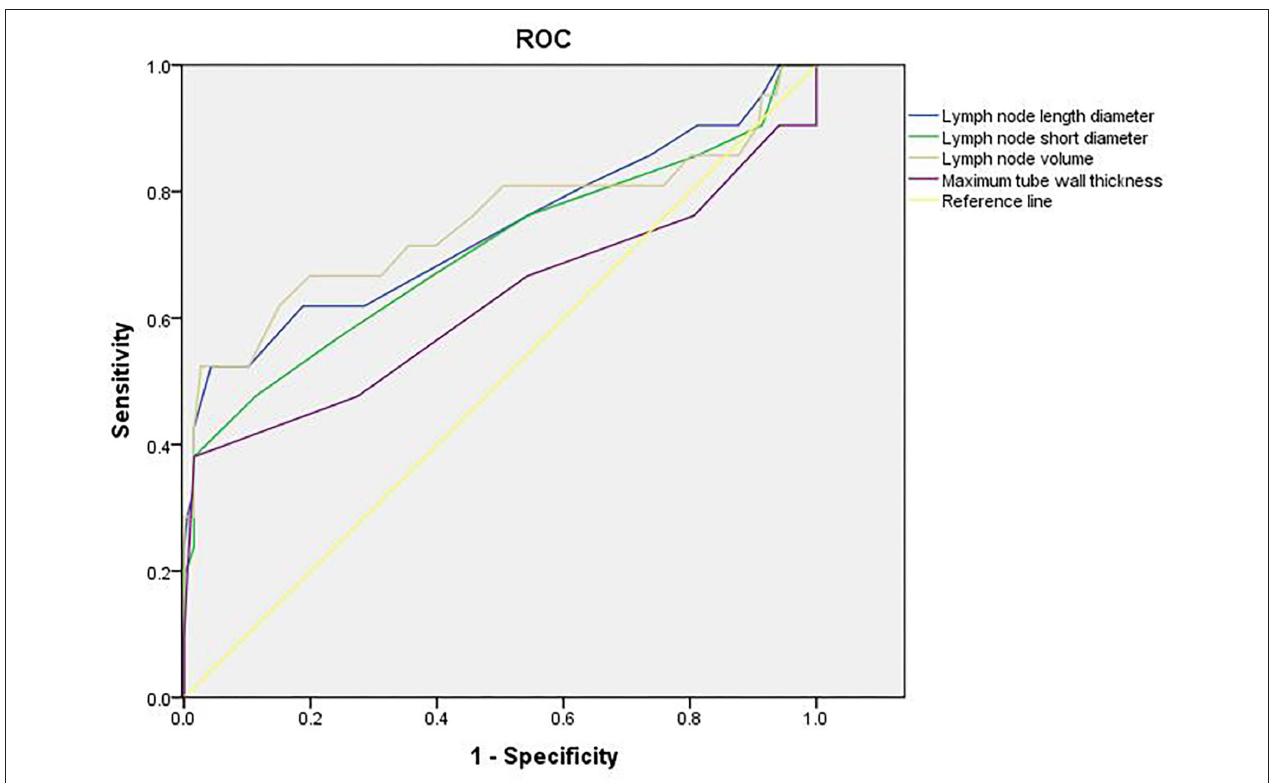
FIGURE 4 | Value of imaging results in evaluating short-term efficacy.